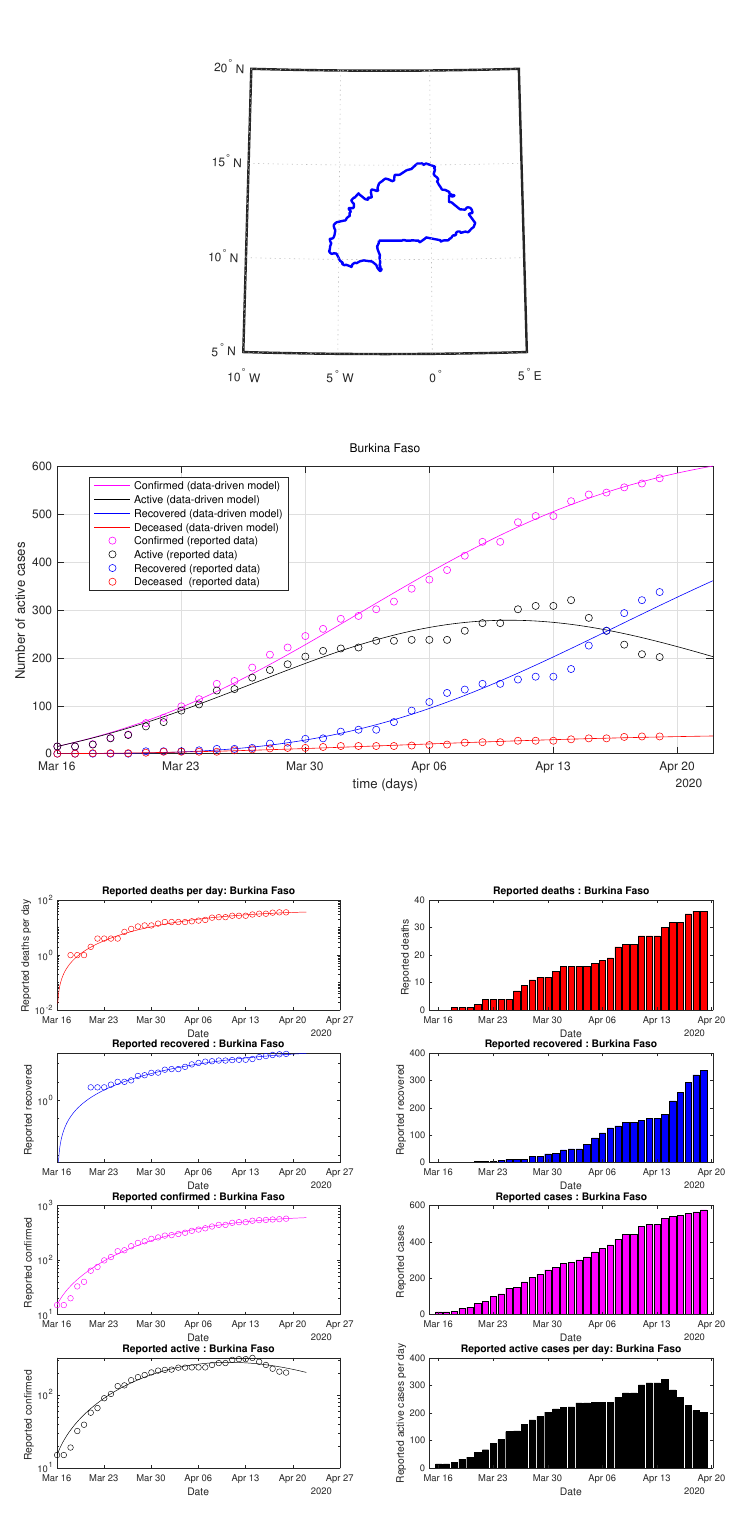
Figure 54. Burkina Faso: data of active, recovered, deceased (in circle or bar) vs. model of active, recovered, deceased over time. Tracking the number of active cases. Predictive analytics for the next couple